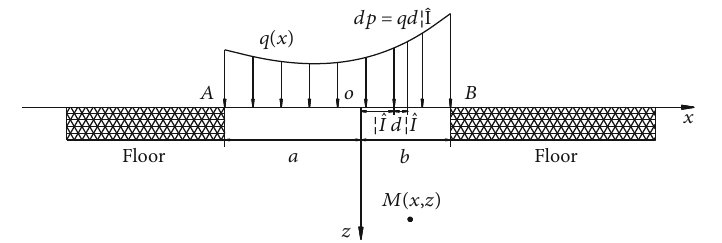
Figure 5: Model of distributed load acting on semi-in fi nite plane